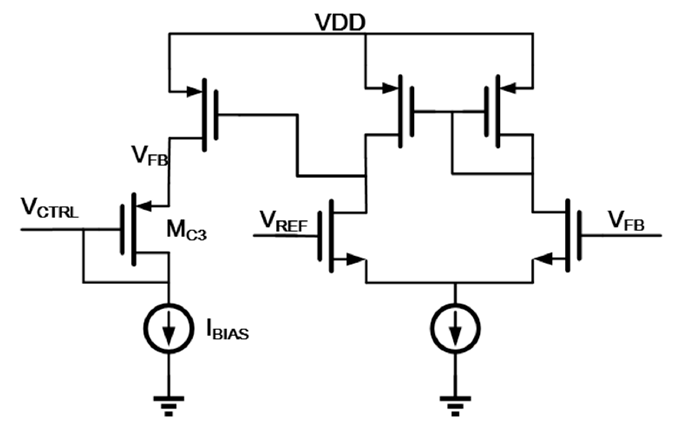
Figure 2. The schematic of control-voltage generator.